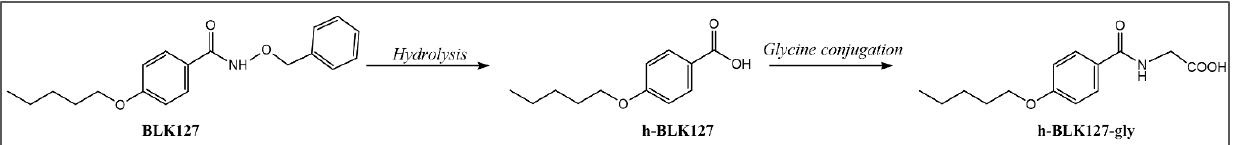
incubation for 24 h.